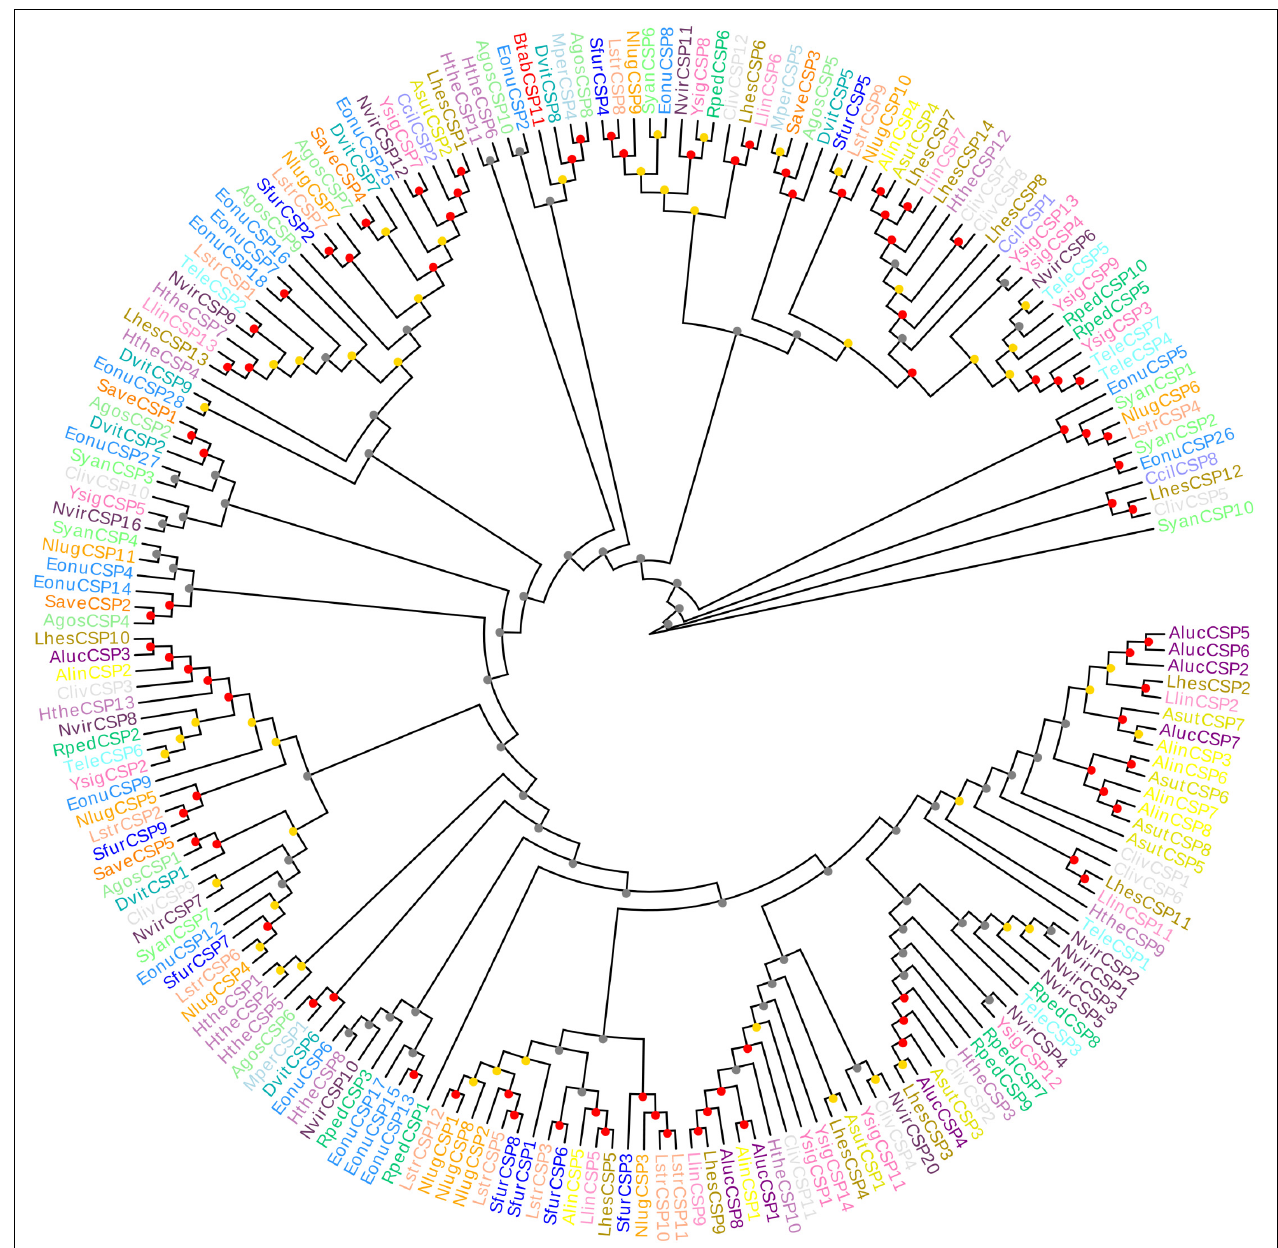
FIGURE 2 | Neighbor-joining phylogenetic tree comparing BtabCSP11 with known hemipteran CSPs. Species were grouped by different colors. Bootstrap values were calculated with 1,000 replications, and bootstraps were marked on the nodes (0–40 gray, 40–80 yellow, 80–100 red). The protein names and sequences of the 200 CSPs used in this analysis are listed in Supplementary Table S2 . Alin = Adelphocoris lineolatus , Agos = Aphis gossypii , Aluc = Apolygus lucorum , Mper = Myzus persicae , Nlug = Nilaparvata lugens , Sfur = Sogatella furcifera , Ccil = Corythucha ciliata , Syan = Subpsaltria yangi , Asut = Adelphocoris suturalis , Lhes = Lygus Hesperus , Save = Sitobion avenae , Lstr = Laodelphax striatellus , Nvir = Nezara viridula , Hthe = Helopeltis theivora , Ysig = Yemma signatus , Cliv = Cyrtorhinus lividipennis , Eonu = Empoasca onukii , Tele = Tropidothorax elegans , Rped = Riptortus pedestris , Llin = Lygus lineolaris , Dvit = Daktulosphaira vitifoliae and Btab = Bemsia